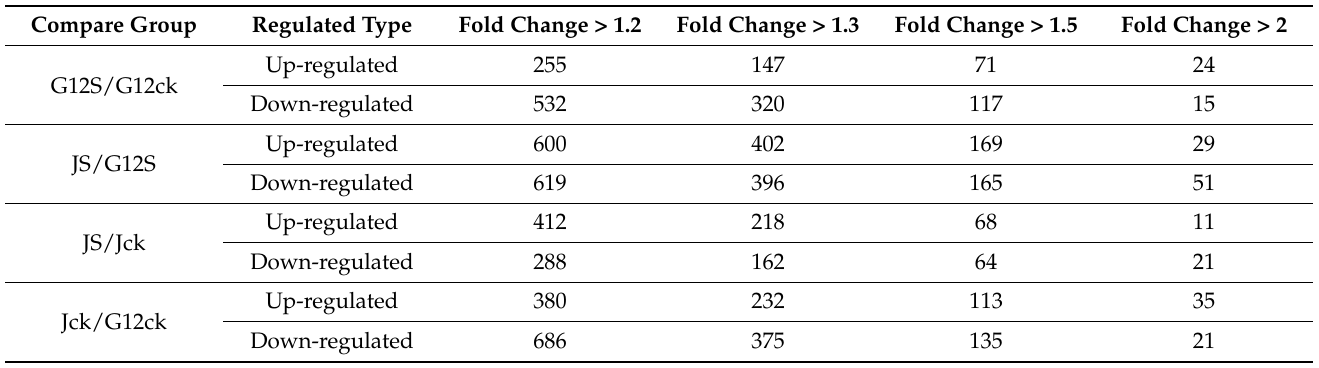
Figure 2. Physiological responses of mulberry to salt stress. ( A ) Net photosynthetic rate of mulberry leaves in both J and G12 groups. ( B ) Relative water content in both J and G12 groups. ( C ) Intercellular carbon dioxide concentration in both J and G12 groups. ( D ) Stomatal conductance to water vapor in both J and G12 groups. Data are means ± SD with three biological replicates. Different letters represent statistically significant differences between control and salt treated plants by Duncan’s multiple range test ( p < 0.05). Jck, JS, G12ck and G12S represent the two states of Jisang3 and Guisangyou12 under control and salt stress, respectively. Table 1. Differentially expressed protein summary (filtered with threshold value of expression fold change and p value < 0.05). Jck, JS, G12ck and G12S represent the two states of Jisang3 and Guisangyou12 under control and salt stress,